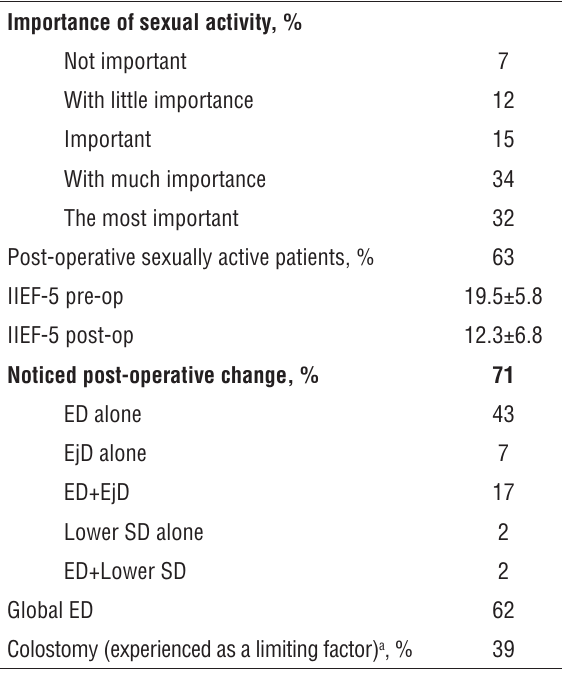
Table 2 – Patients’ perception about importance of sexual activity and changes of sexual function after surgery – results of a self-evaluation tool.